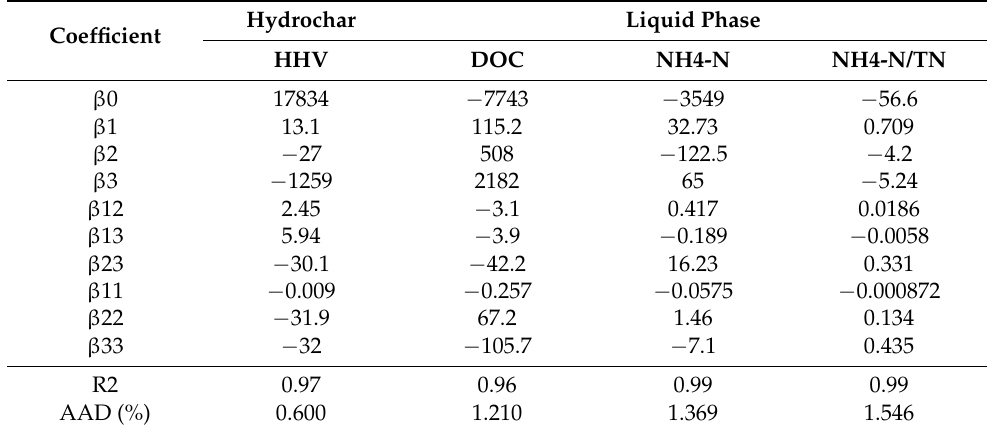
Table 3. Decoded constants, coefficients of the BBD and the corresponding R 2 and AAD for RS1.